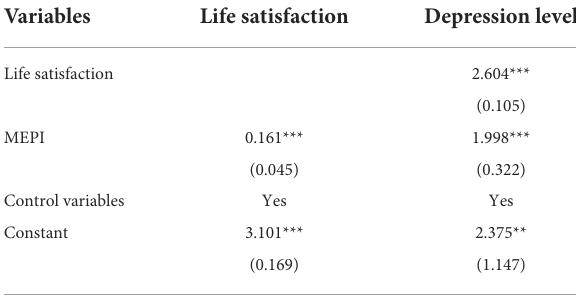
TABLE 10 Results of SEM.